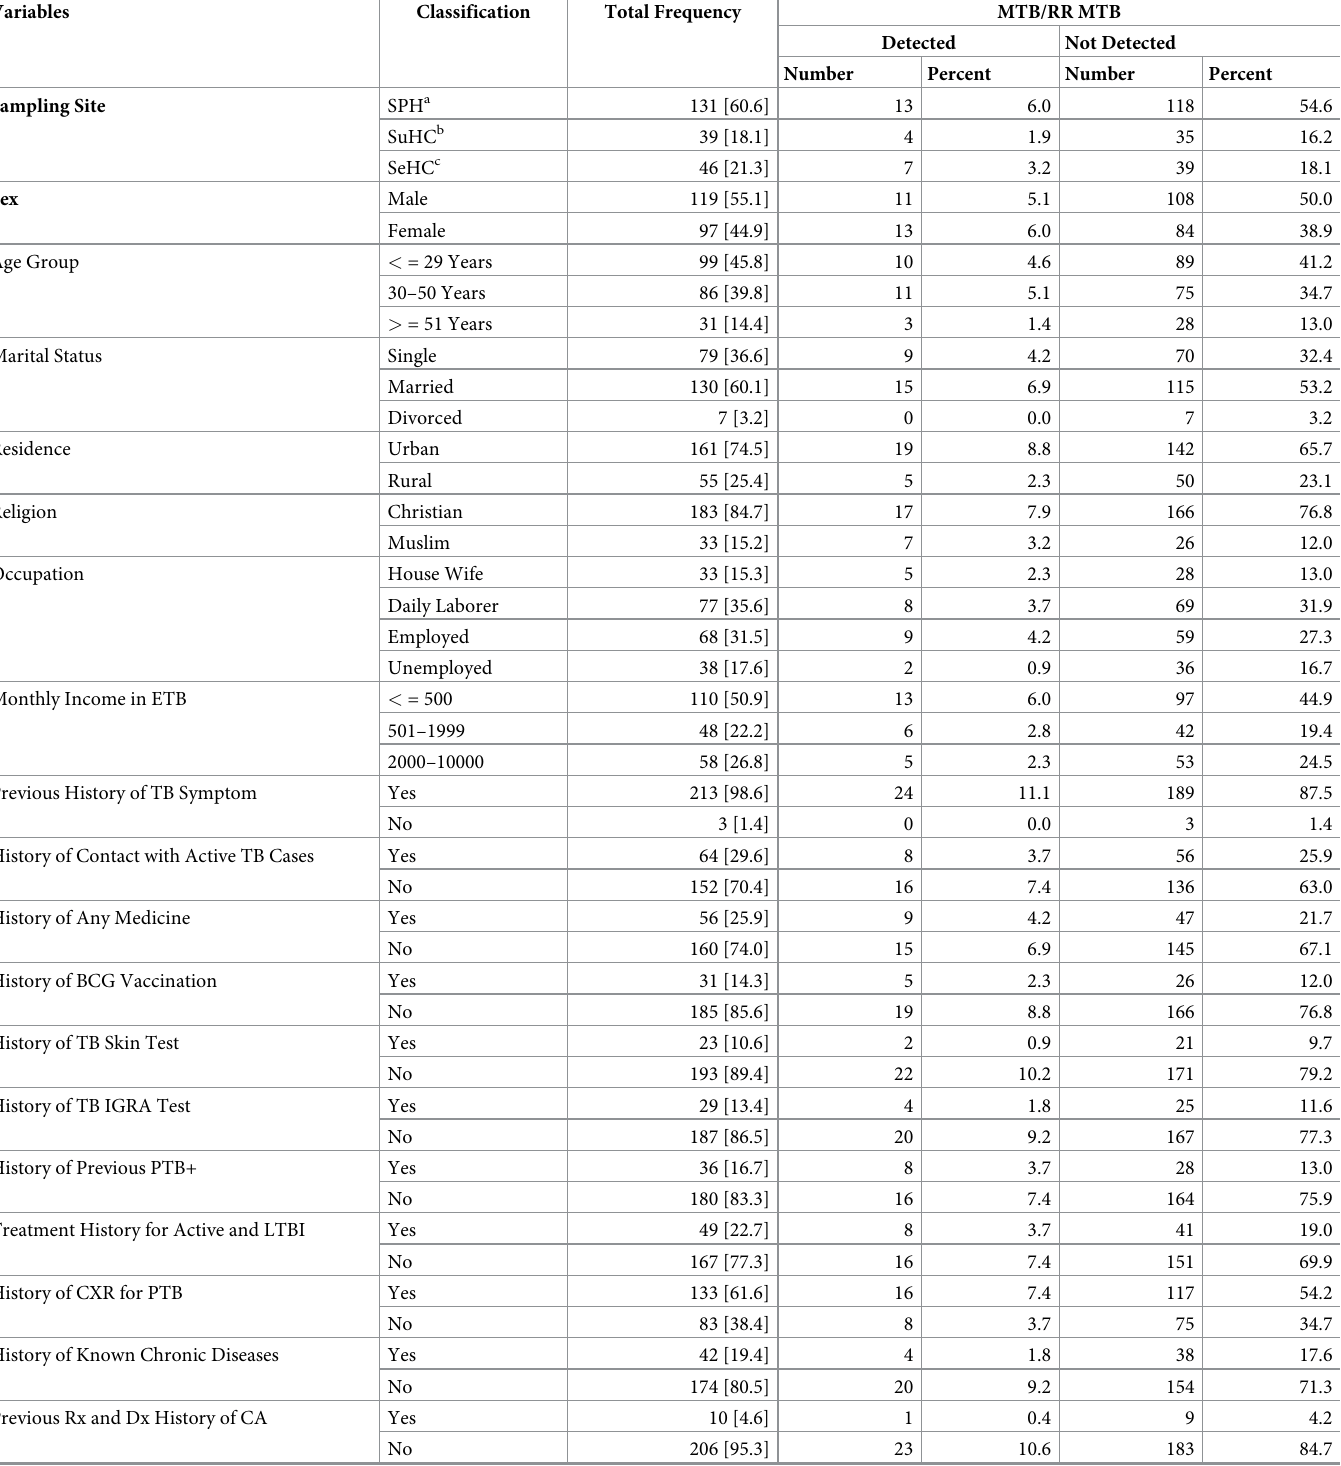
Table 1. Sociodemographic characteristics and proportion of MTB/RR TB among study participants in Addis Ababa from October 2019 to March